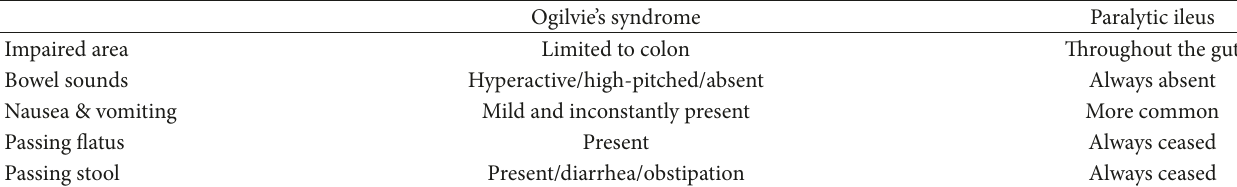
Table 1: Compares between Ogilvie’s syndrome and paralytic